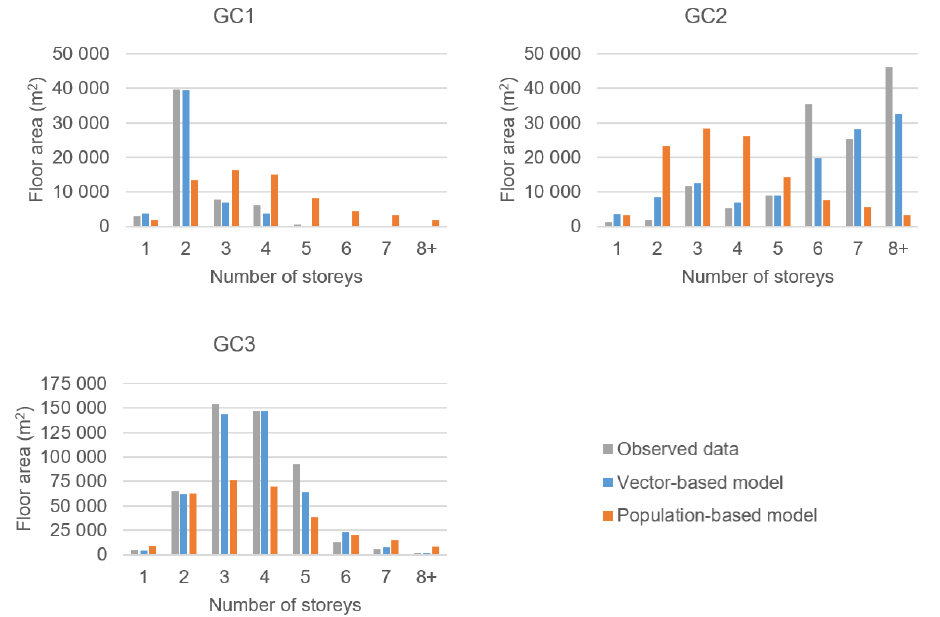
Figure 9. Residential building floor areas per height class, from the vector- and population-based exposure models, as well as the observed data, for three grid cells with different predominant building typologies.